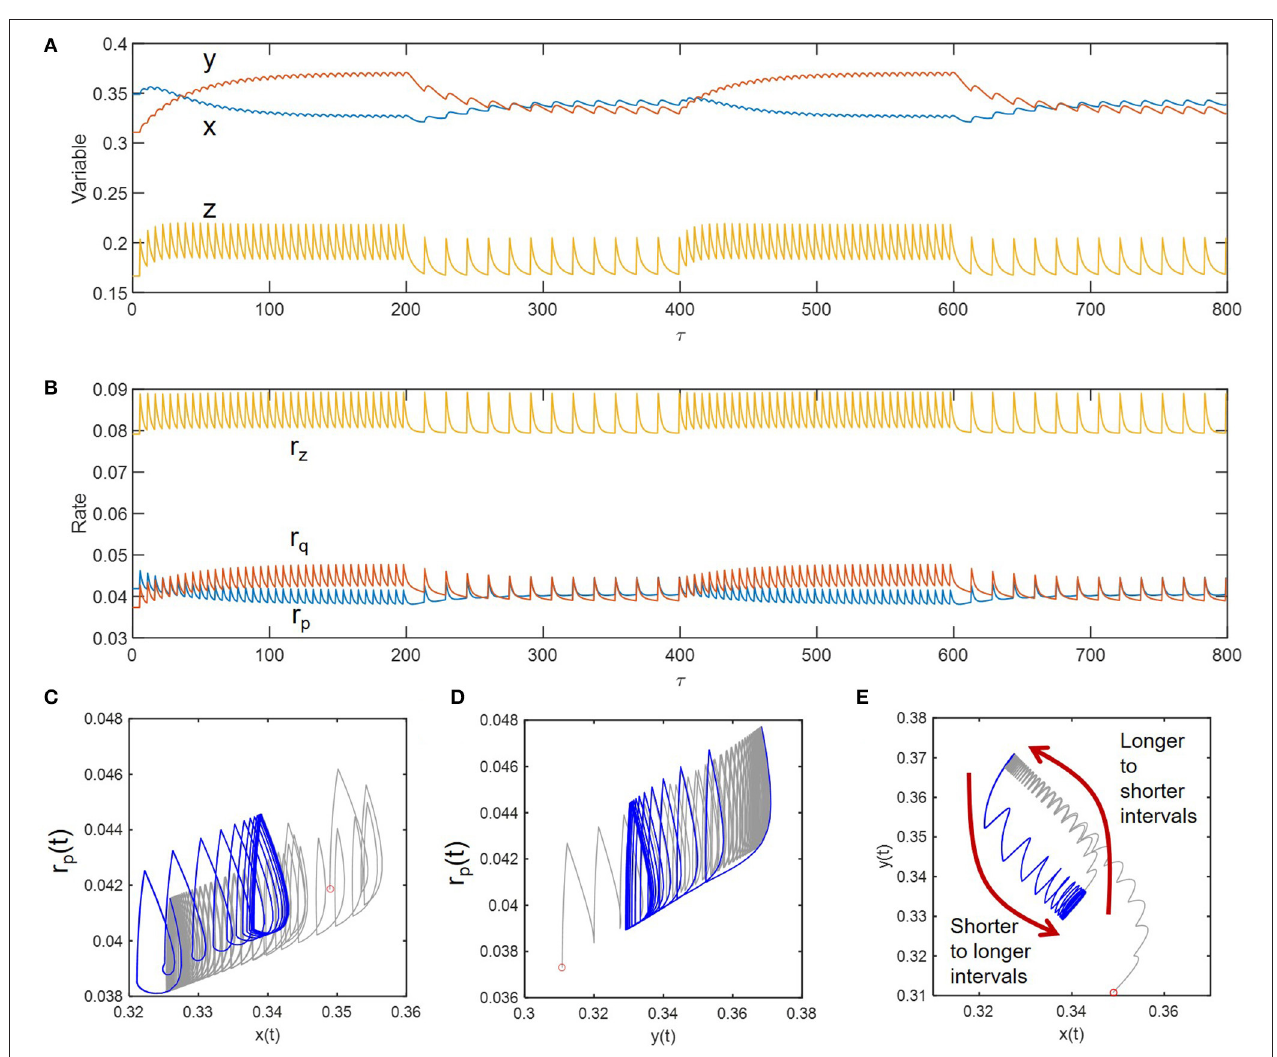
FIGURE 5 | Hysteresis in dynamic transitions between the two distinctively perturbed conditions with the intervals of 5 and 15: (A) compositional fluctuations, (B) functional fluctuations, and (C–E) phase diagrams. Curves in gray and blue, respectively denote the transitions from longer to shorter intervals and from shorter to longer